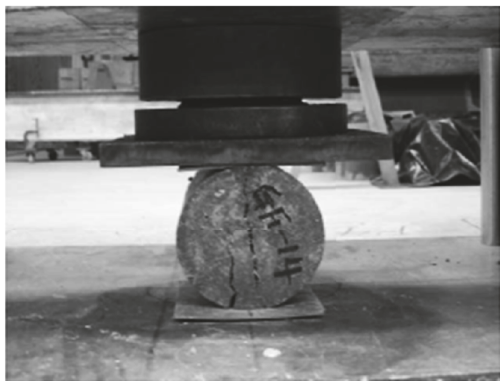
Figure 3: Splitting tensile strength test in